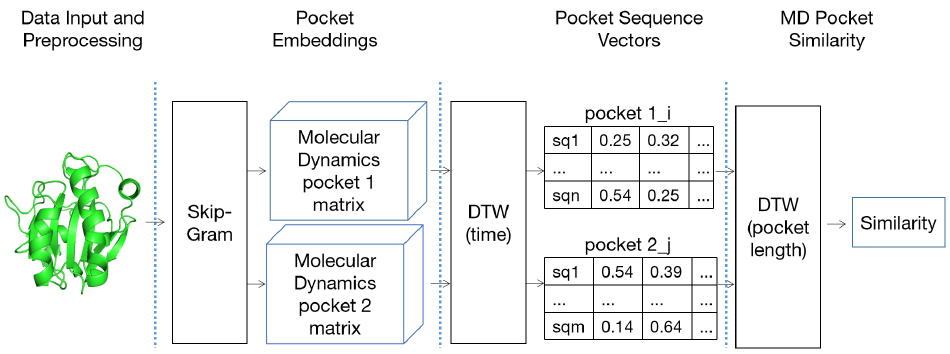
Figure 6. Dynamic pocket extraction and P2V-DTW similarity calculation